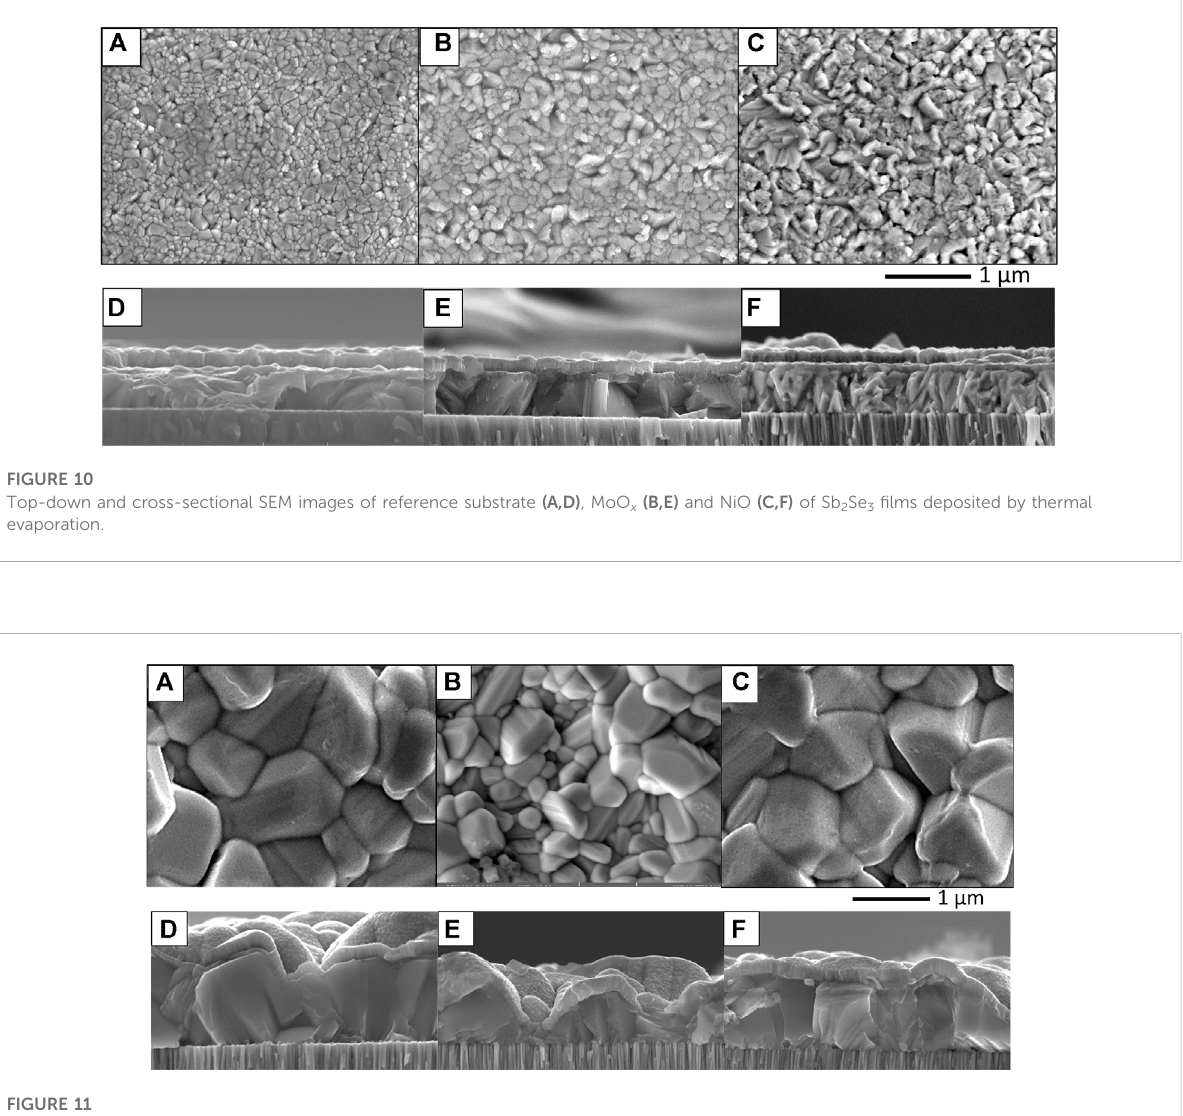
FIGURE 11 Top-down and cross-sectional SEM images of reference substrate (A,D) , MoO x (B,E) and NiO (C,F) of Sb 2 Se 3 fi lms deposited by close-space